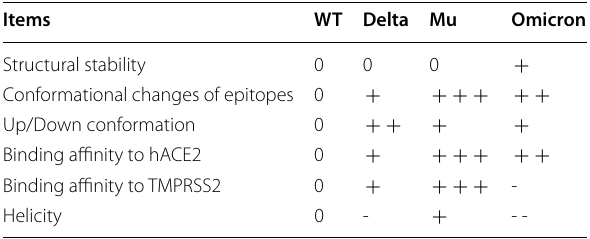
Table 3 Comprehensive comparison of SP WT with